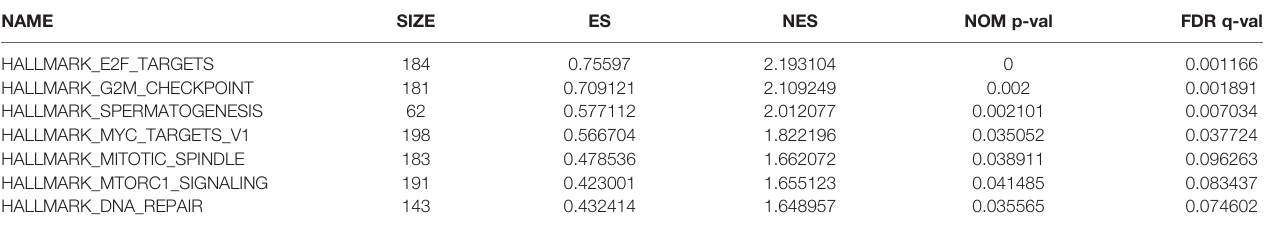
TABLE 2 | The 7 gene sets identi fi ed by GSEA in TP53-mutated HCC